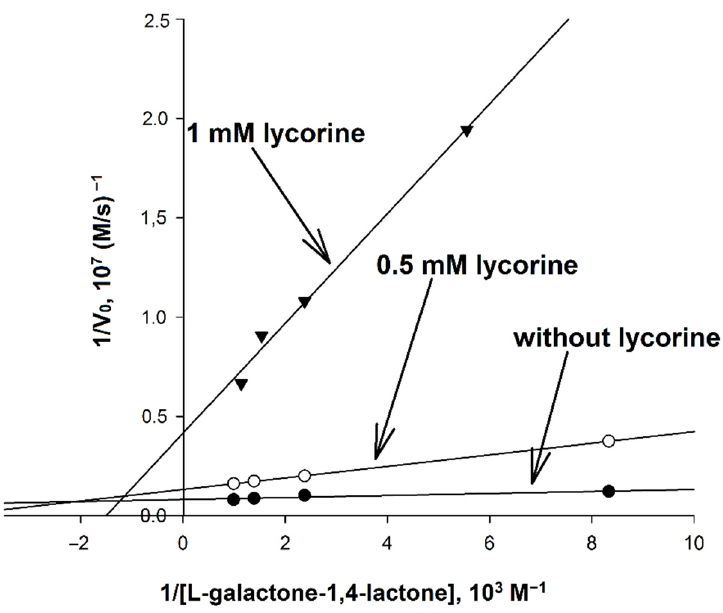
Figure 6. Determination of the mechanism of inhibition of AtGALDH by lycorine. The concentration of AtGALDH was 6 × 10 − 9 M. Concentrations of L -galactone-1,4-lactone were in the range of 0.12–1.01 mM at fixed concentrations of the inhibitor (0, 0.5 and 1 mM). Measurements were performed in in aqueous medium (25 mM phosphate buffer, pH 8.8). The parameters have maximal error values of 10%.